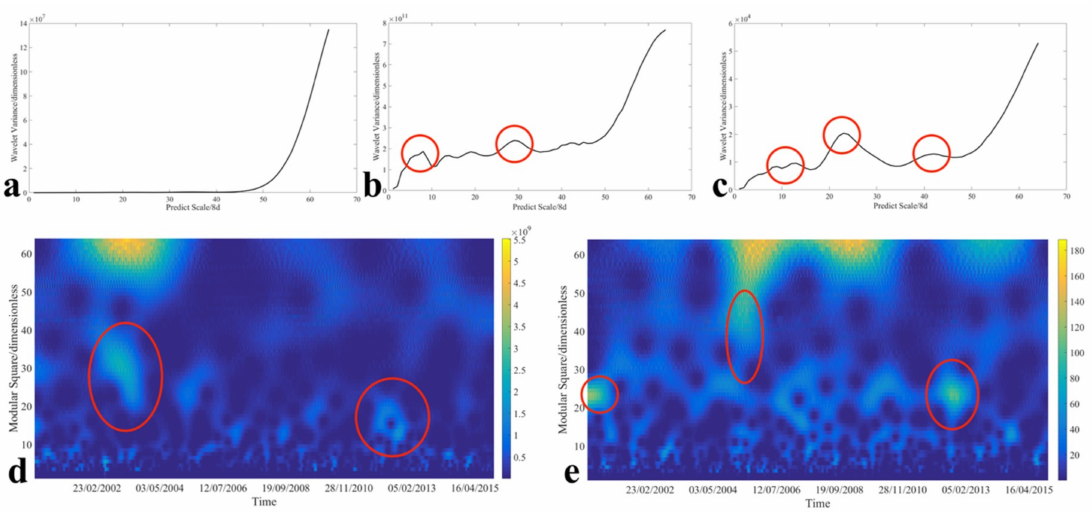
Figure 2. Results of the wavelet analysis of air temperature, precipitation, and wind speed, with eight days used as the time period. The curves of the wavelet variance for temperature ( a ), precipitation ( b ), and wind speed ( c ); the red circles represent prominent periods in this numerical region. The wavelet power spectrum for precipitation ( d ) and wind speed ( e ); the red circles represent prominent periods in this numerical